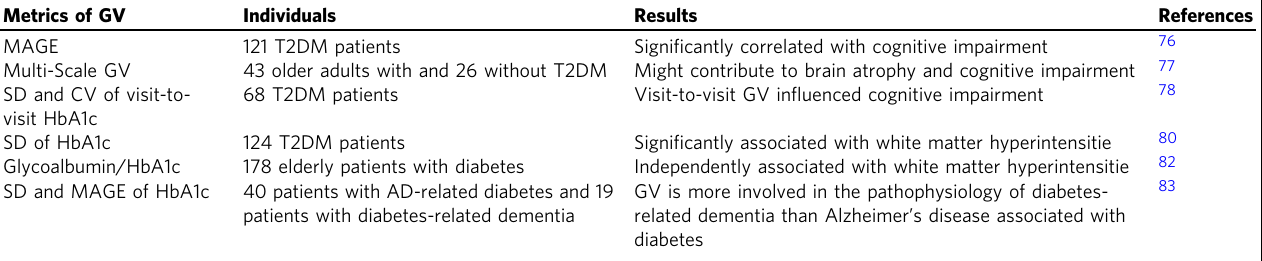
Table 3 Roles of GV in cognitive impairment.